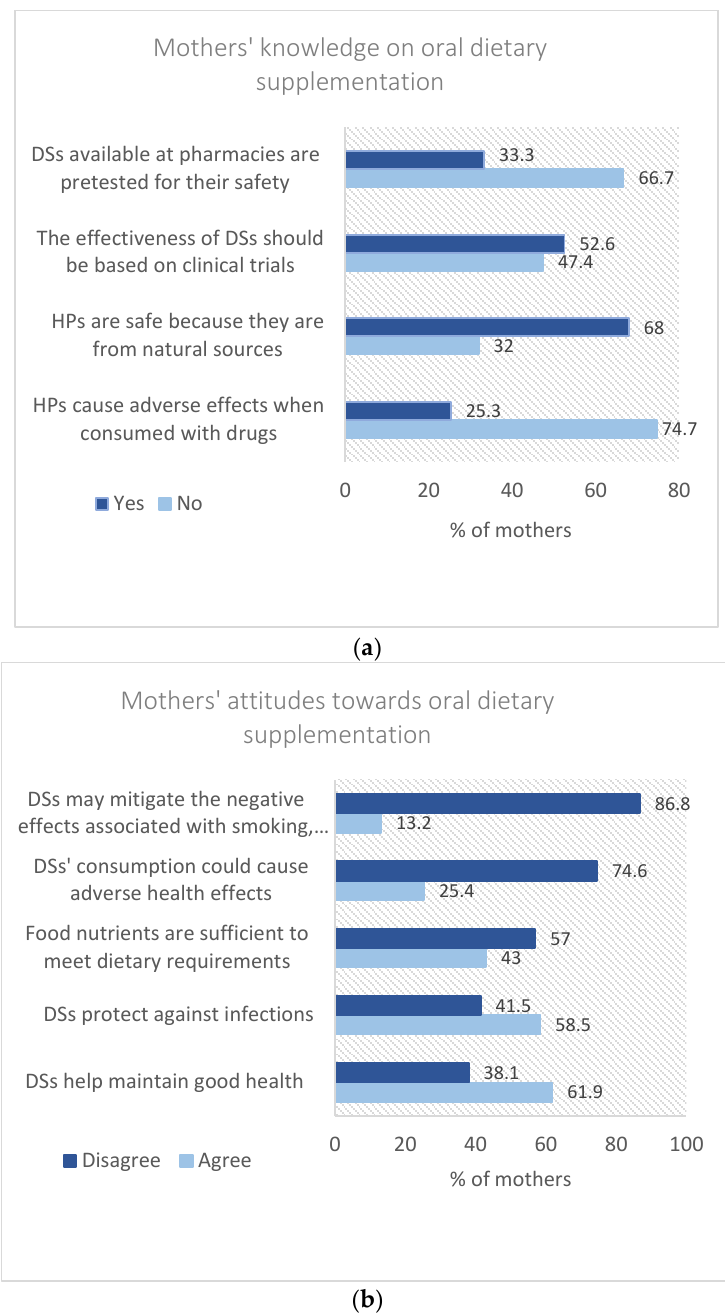
Figure 1. ( a ) Mothers ’ knowledge on oral dietary supplementation. HPs: herbal products; DSs: dietary supplements. ( b ) Mothers ’ attitudes towards oral dietary supplementation. DSs: dietary supplements.